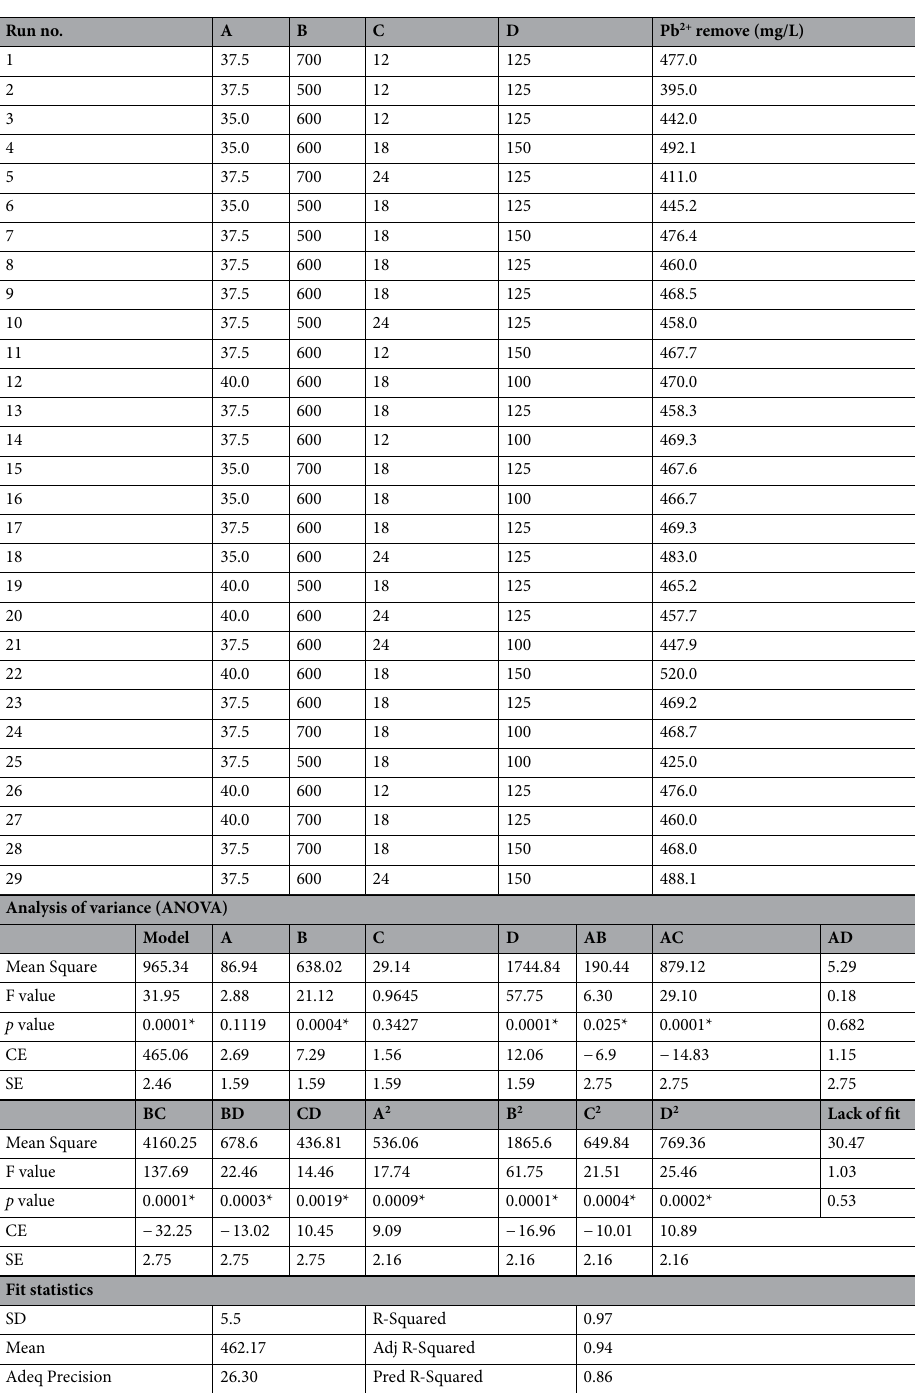
Table 4. Box–Behnken design matrix and the actual values, analysis of variance (ANOVA), and fit statistics of variables affecting lead metal removal by dead biomass of 17OS strain. A Temperature degree, B Metal concentration, C Incubation periods and D Agitation speed. Mean 2 = Mean Square P corresponding level of significance, F corresponding level of significance, CE Coefficient Estimate, SE Standard Error, SD Standard Deviation, R 2 Determination coefficient, Adj . Adjusted, Pred . Predicted, Adeq . Adequate. *Significant at 5% level ( p <